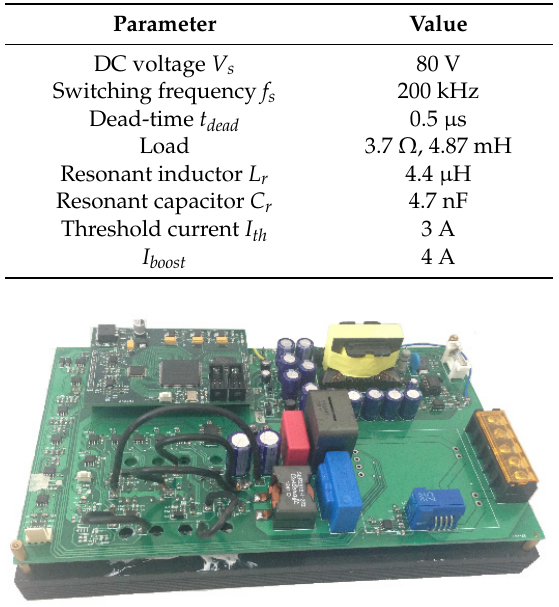
Figure 8. Photograph of the prototype.